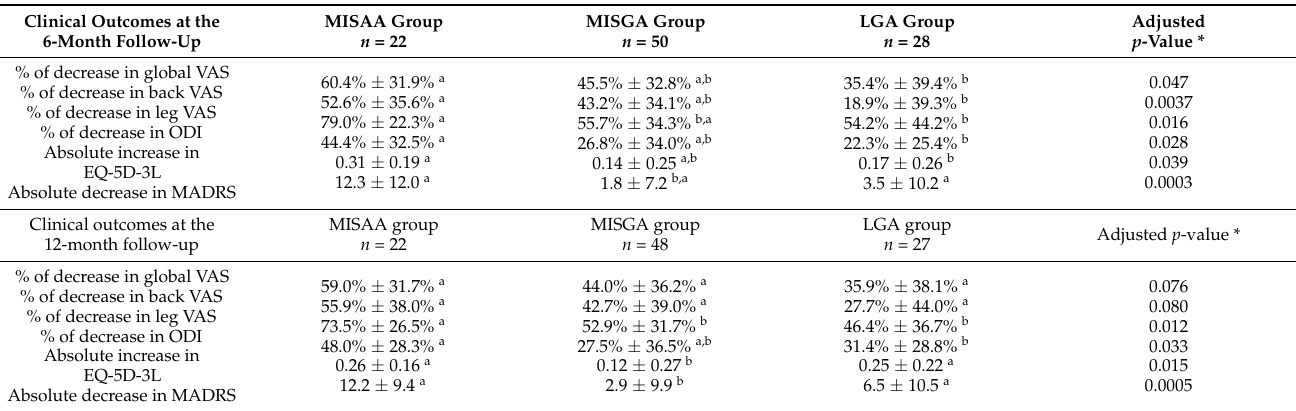
Table 4. Comparison of the clinical outcomes between the AG and TCI groups at the 6- and 12-month